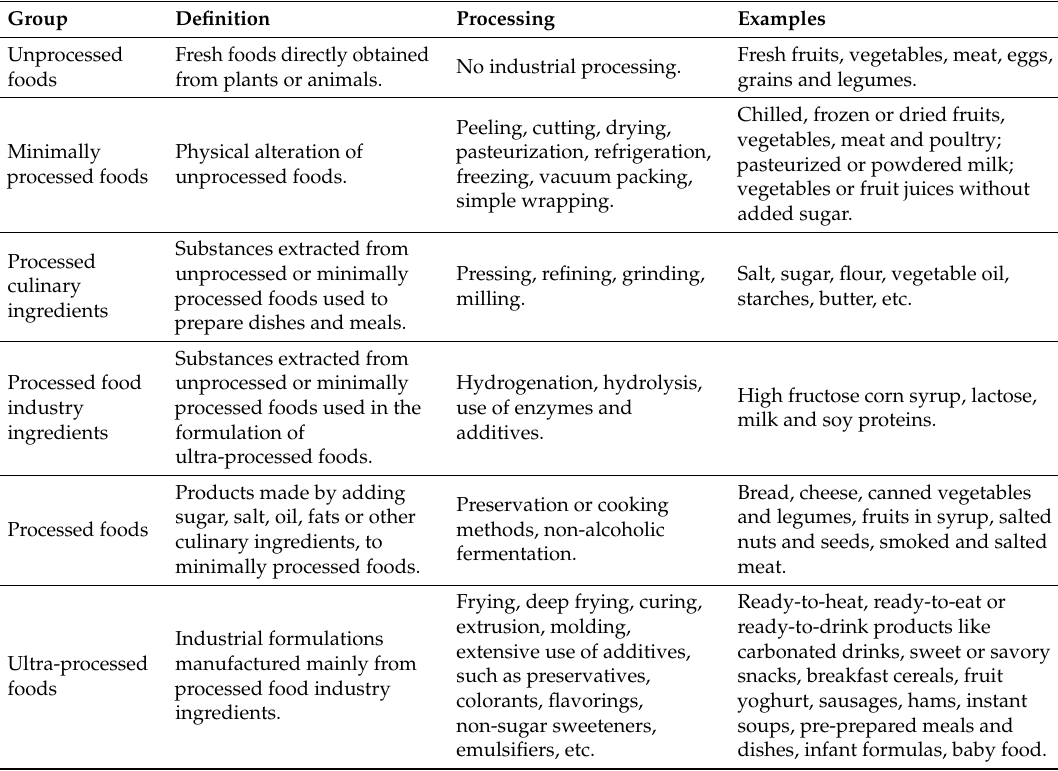
Table 1. Classification of food according to its processing degree